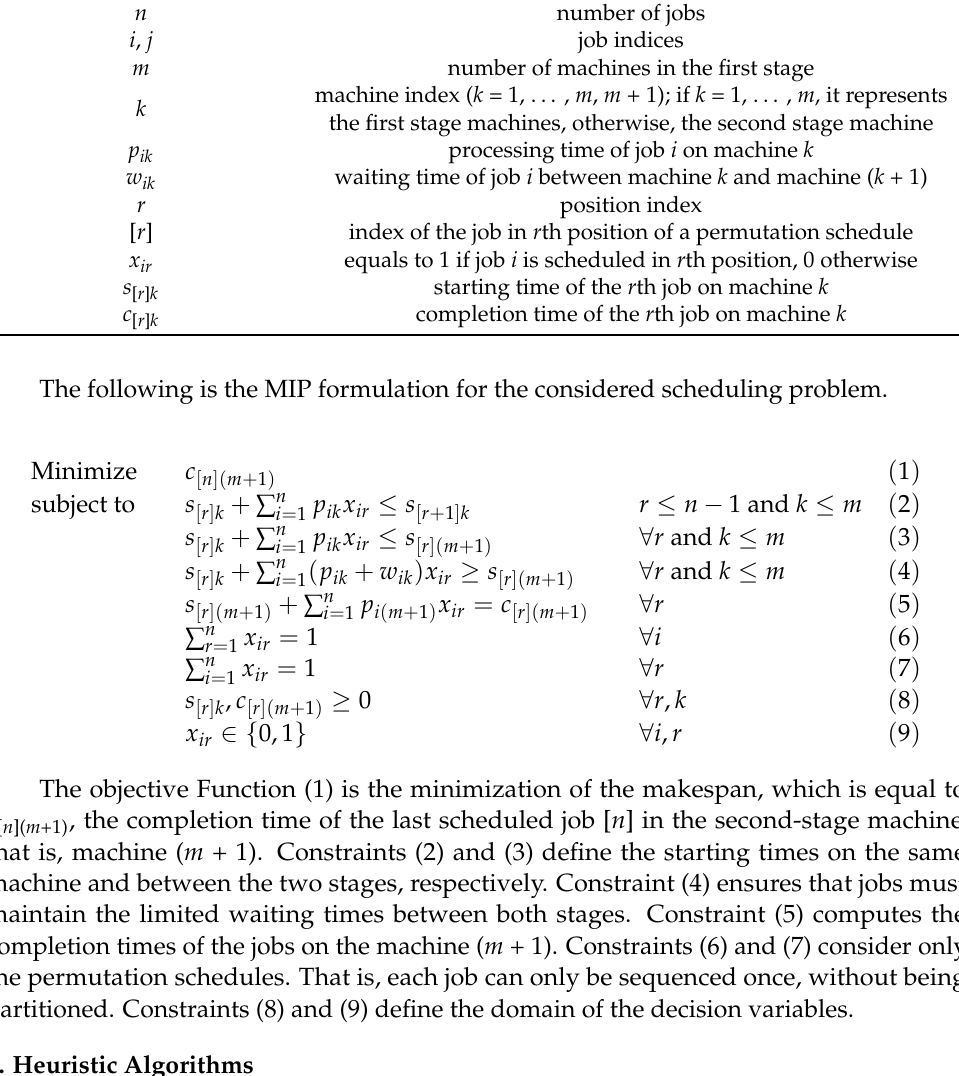
Table 1. Notation for the description of the algorithms proposed in this study. Symbol Definition n number of jobs i , j job indices m number of machines in the first